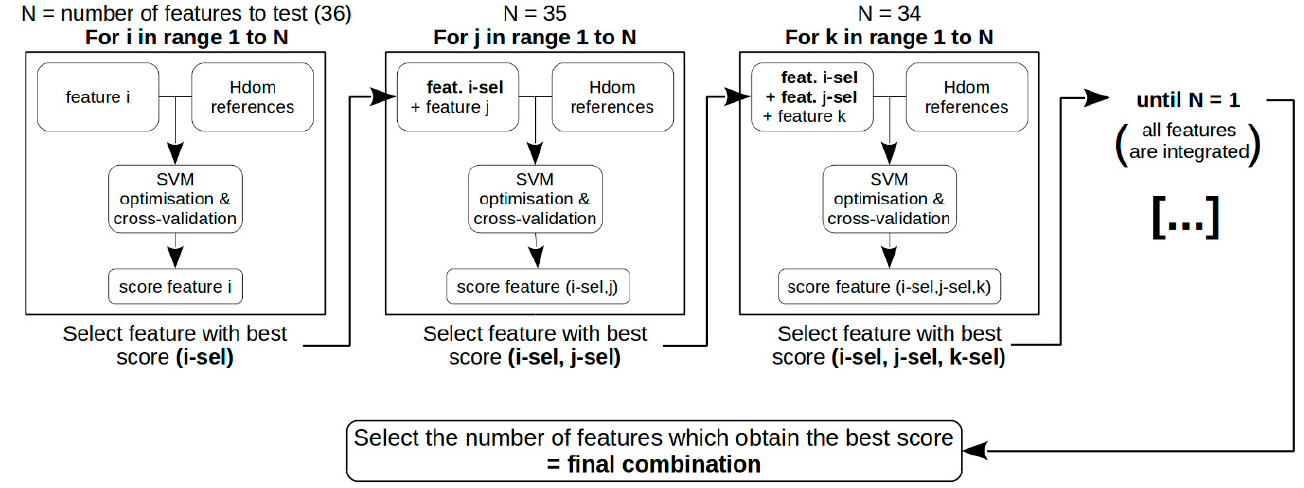
Figure 2. Overall processing chain with the example of using a forward stepwise selection on 36 features. 36